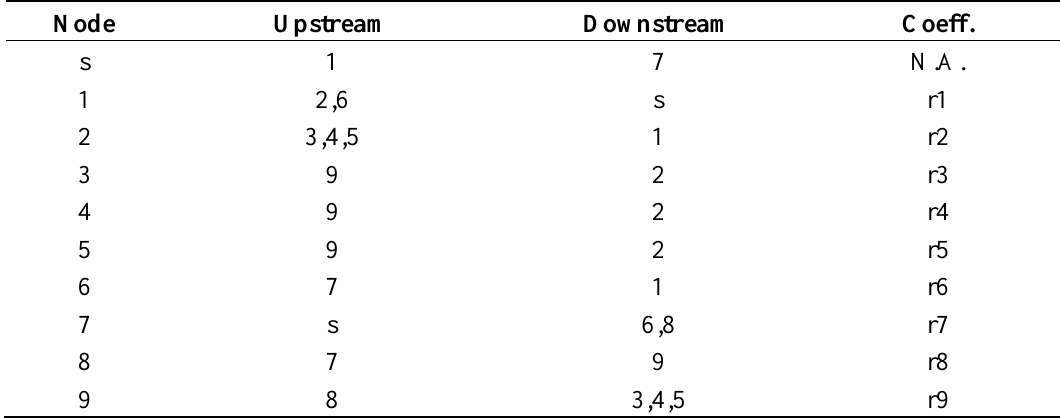
Table 1. Routing & coefficients table of Figure